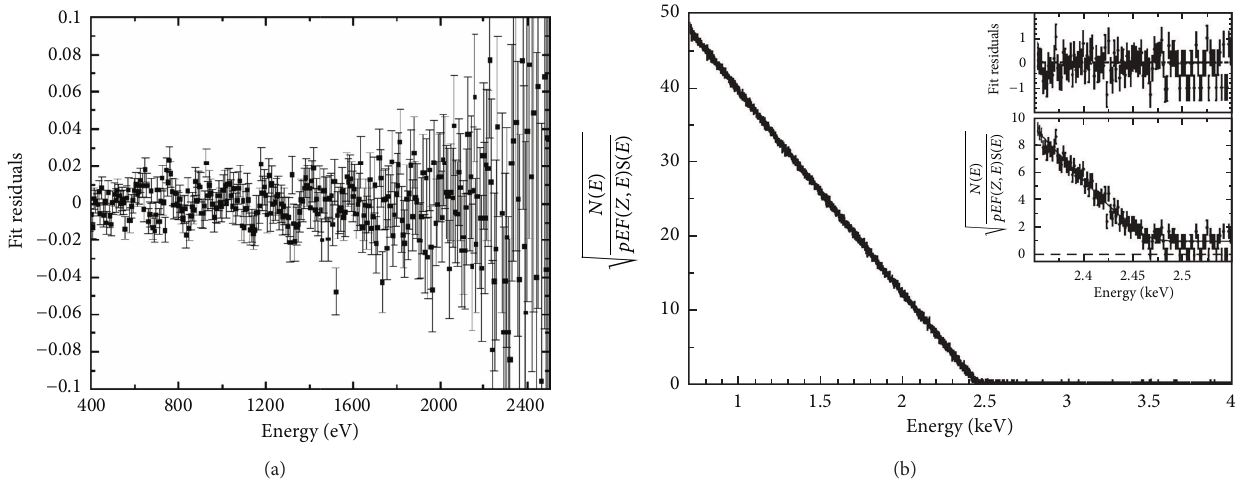
Figure 14: (a): The residuals of the theoretically expected 187 Re 𝛽 -spectrum that has been fitted to thedata collected by the MANU experiment exhibit effects of a 𝛽 -environmental fine structure (BEFS) modulation most clearly visible at low electron energies (Reprinted with permission from [82], Copyright (2000) by the American Physical Society). (b): Kurie plot of the experimental 187 Re 𝛽 -spectrum obtained by the MiBeta collaboration (reprinted with permission from [83], Copyright (2006) by the American Physical